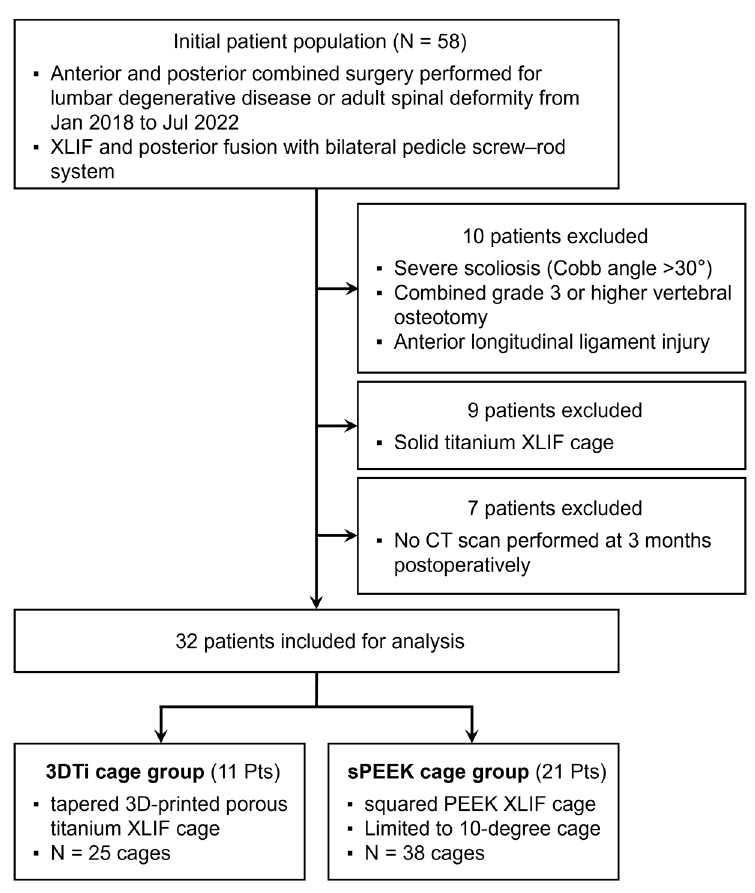
Figure 2. Flowchart for patients’ selection.